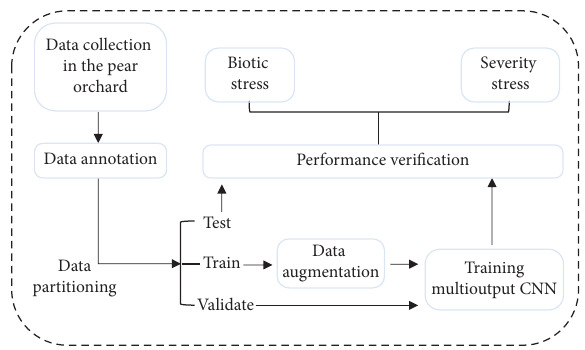
Figure 1: System overview of the proposed deep-learning-based approach to diagnose plant diseases.